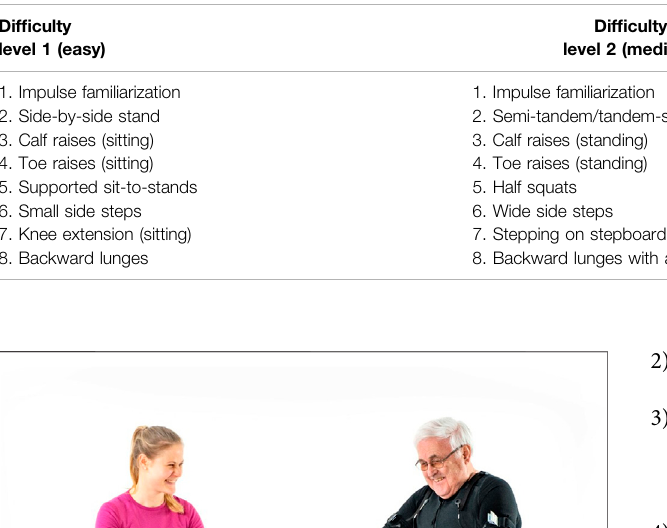
TABLE 1 | Training program by levels of dif fi culty.